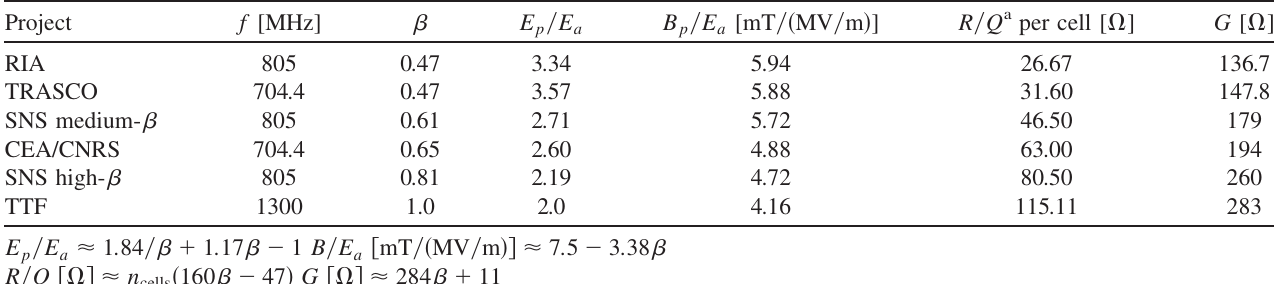
TABLE VII. Cavity parameters for different geometric (cid:1) values from various projects. Project